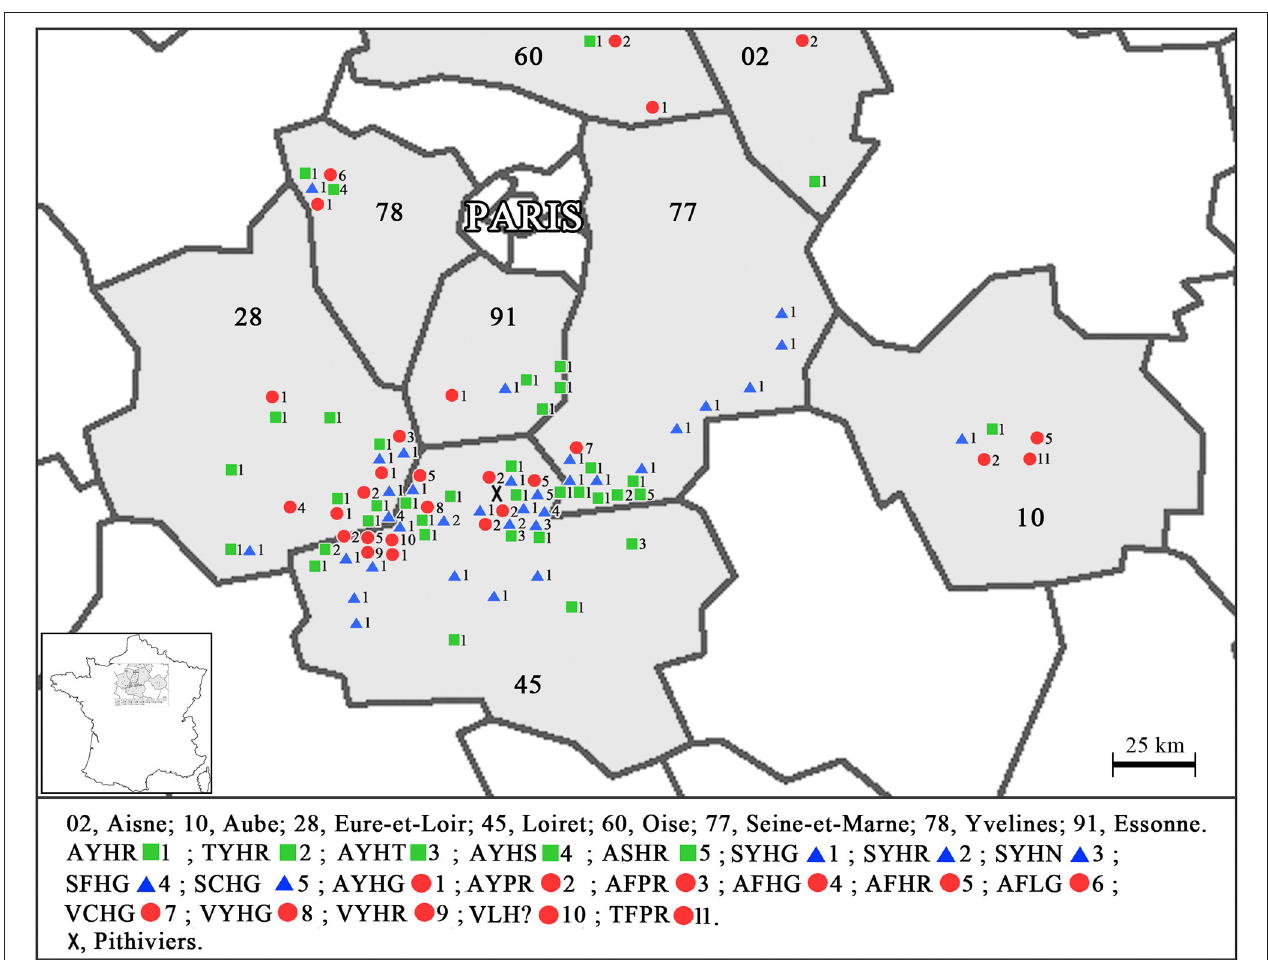
FIGURE 1 | Distribution of Beet necrotic yellow vein virus (BNYVV) and the associated tetrads in the Pithiviers region of France. The figure shows all the tetrad diversity of BNYVV and their dispersion around Pithiviers (X). The sequences represented by a square are associated with the B-type, those represented by a circle are associated with the A-type and those represented by a triangle are associated with the BNYVV